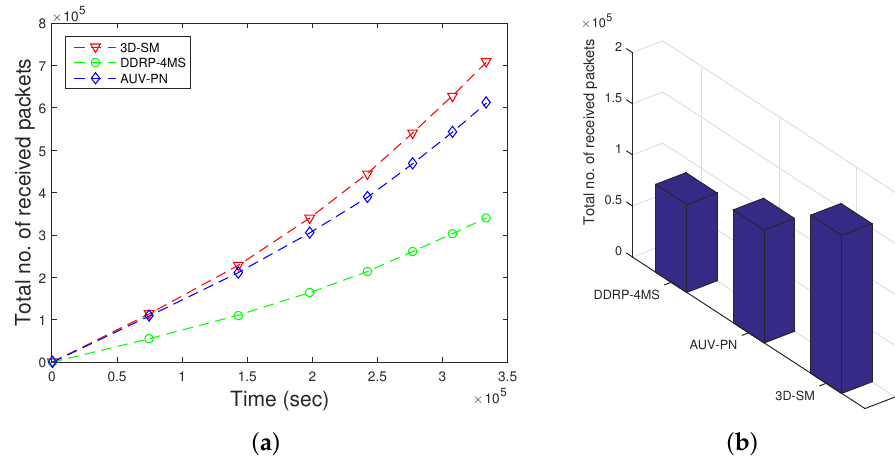
Figure 9. Network throughput. ( a ) when all nodes die; ( b ) when first node dies.